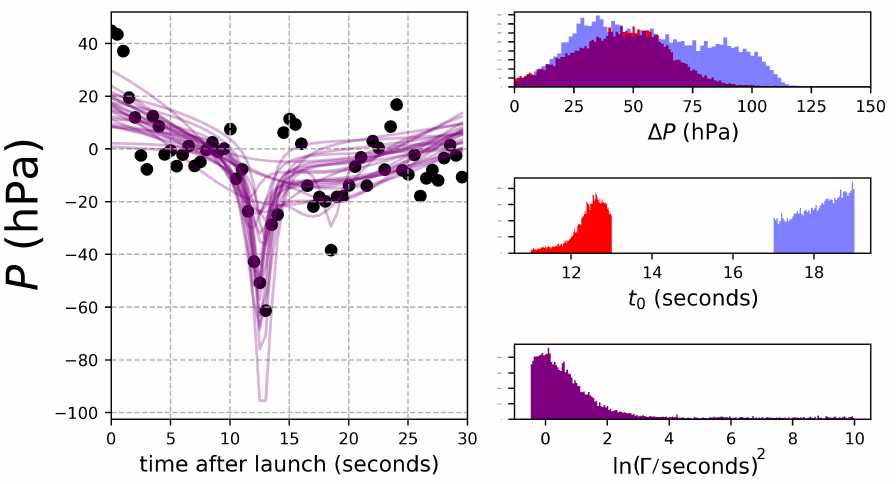
Figure 10. The left panel shows the two-Lorentz profile fits to the pressure time-series from Flight 0. The right panels show the best-fit parameters for the two Lorentz profiles—the red histograms for the earlier encounter, the blue, for the later.